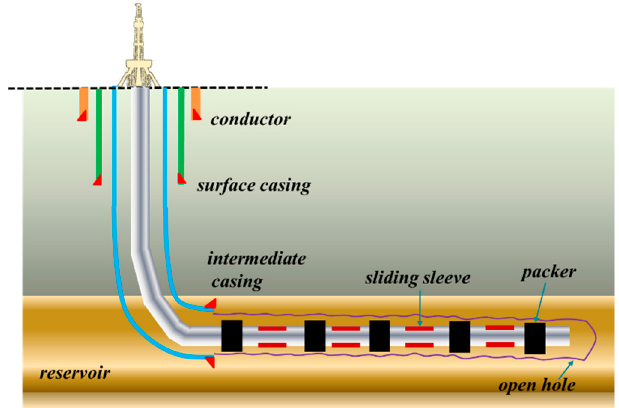
Figure 1. Schematic of the completion string with packers in the horizontal well.